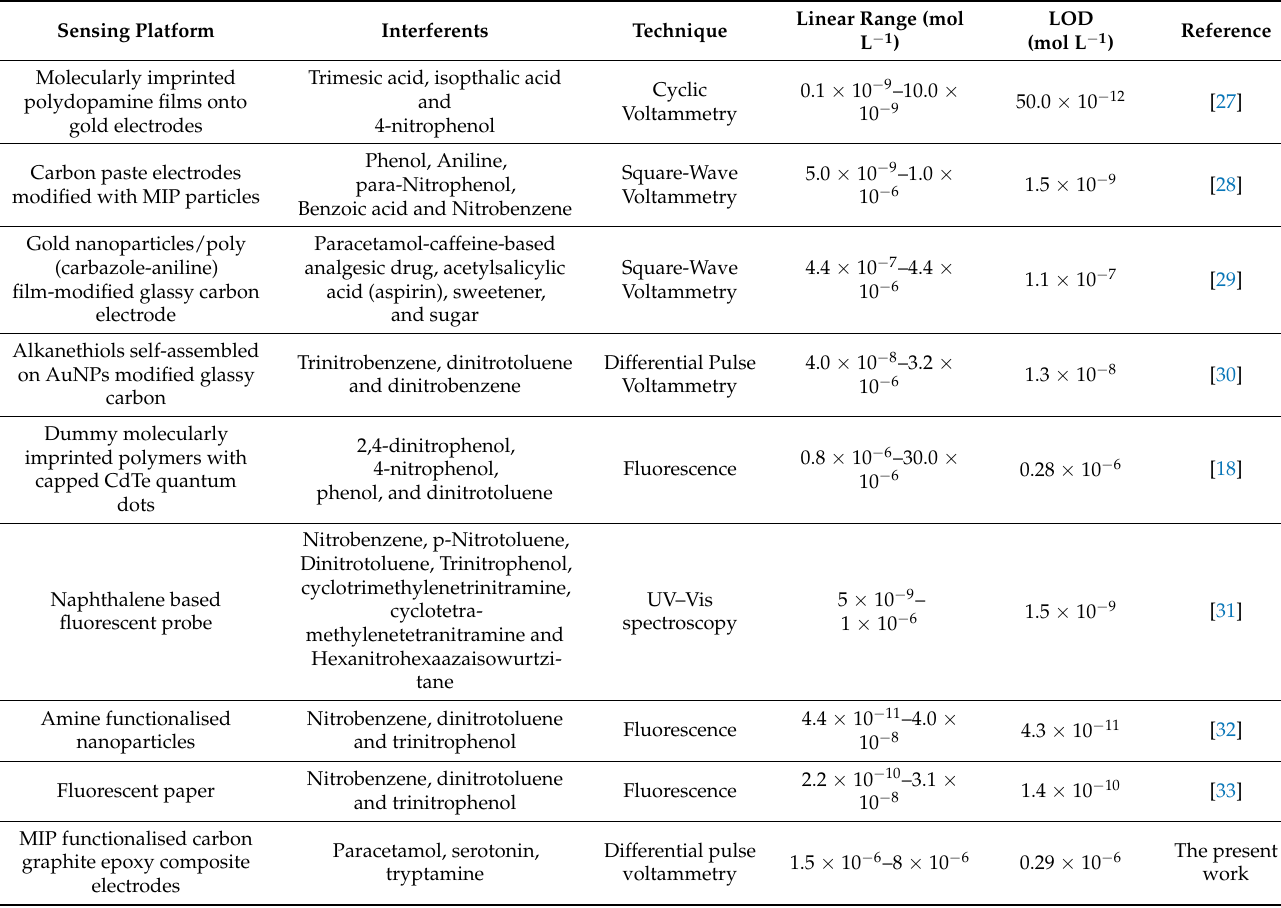
Table 1. Summary of recent studies dedicated to the detection of TNT, detailing the strategy and technique employed, linear range and limit of